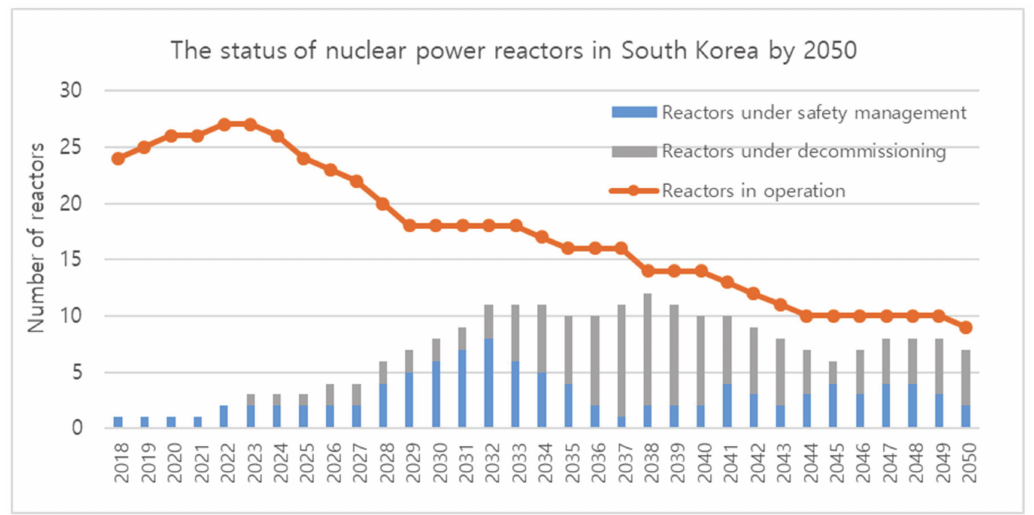
Figure 1. The status of nuclear power reactors in South Korea through 2050. Source: authors constructed this chart using